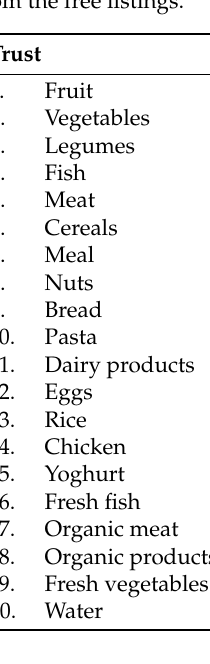
Table 3. Food categories associated with trust ( n = 20) and distrust ( n = 20) in the pile sorts obtained from the free